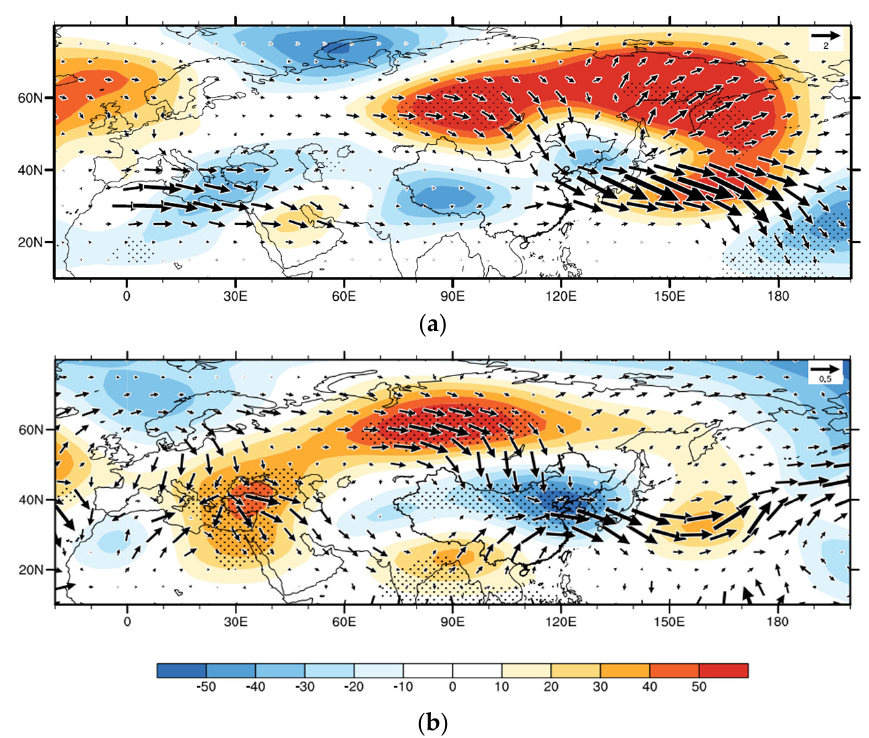
Figure 12. The 10–30-d filtered ( a ) and 30–60-d filtered ( b ) fifth-phase 200-hPa wave activity flux (vector arrow, unit: m 2 ∙ s − 2 ) and height fields (shading, unit: hPa). (Dotted areas are height passing 95% significance test.)